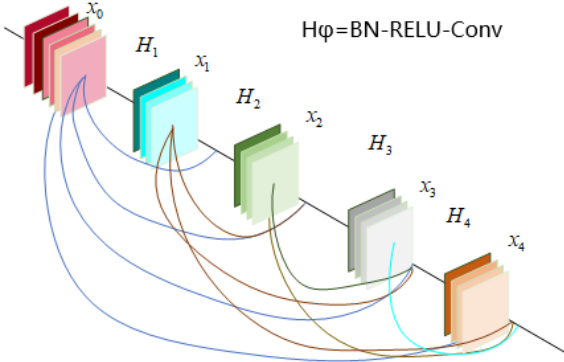
Figure 4. Denseblock module structure diagram.